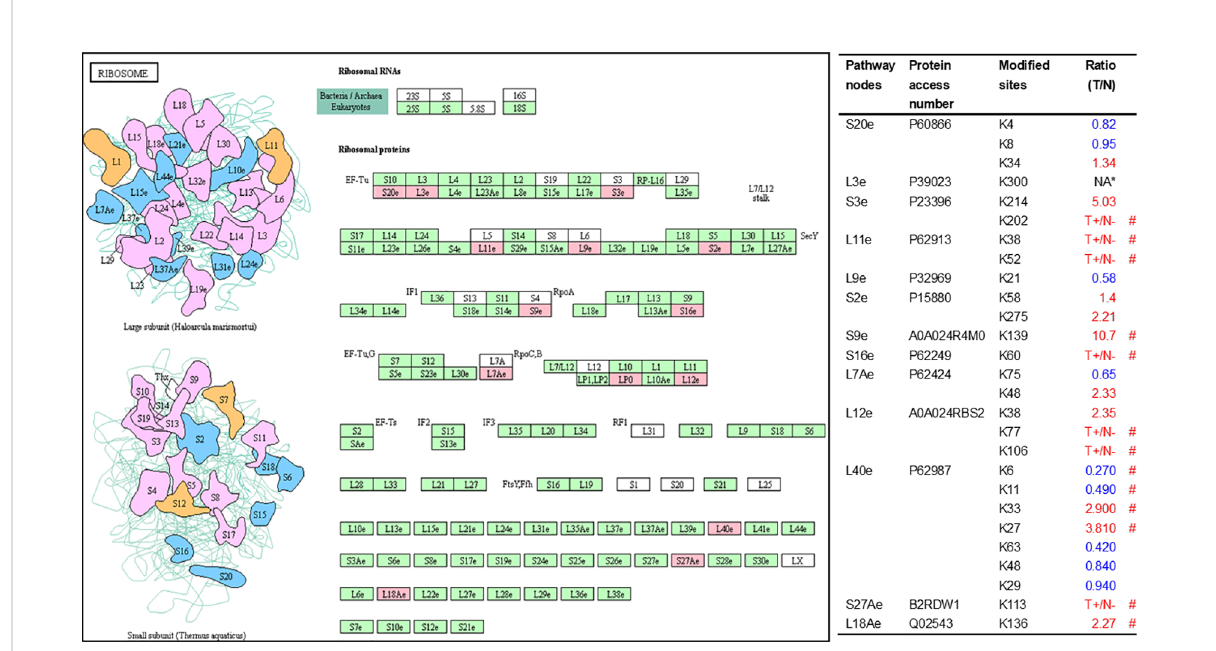
FIGURE 7 Ubiquitination-mediated ribosome pathway. Pink = the identi fi ed ubiquitinated subunits. Green=non-ubiquitinated subunits. K* = ubiquitinated lysine residue. Red indicates the degree of ubiquitination of this site is upregulated, and blue indicates downregulated. Ratio(T/N) = Ratio of tumor to control. T+/N- = ubiquitination only in tumor. NA* means no quantitative information in both tumor and control. # means statistically signi fi cantly altered ubiquitination level in tumor compared to